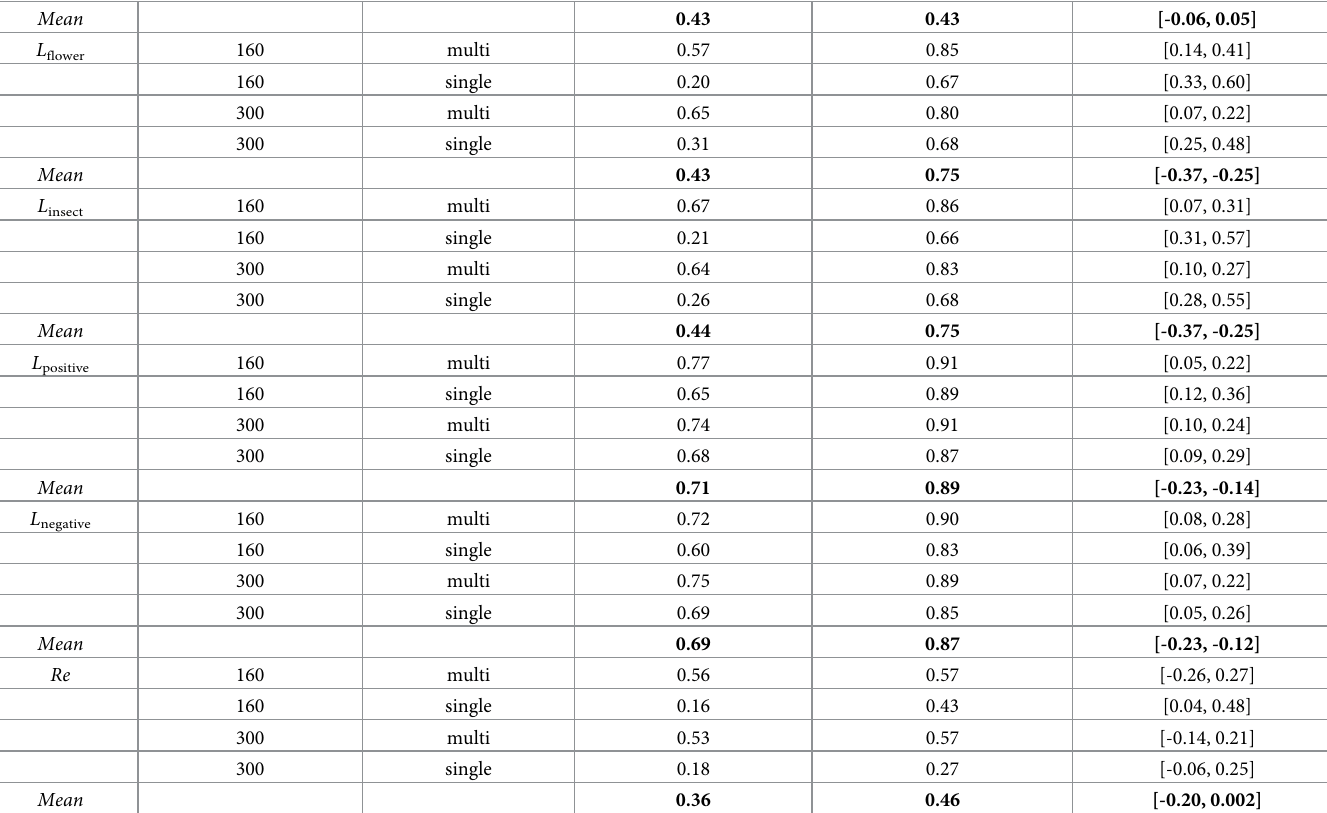
parameters for flowers should not include 0.5 (indicating positive evaluations), and the upper limit of the 95% HDI for A parameters for insects should not include 0.5 (indicating negative evaluations). As a third, more stringent test, we investigated whether A parameters for flowers were reliably greater than A parameters for insects. To do so, we subtracted the posterior dis- tributions of the A parameters for insects from the posterior distributions of the A parameters for flowers in each